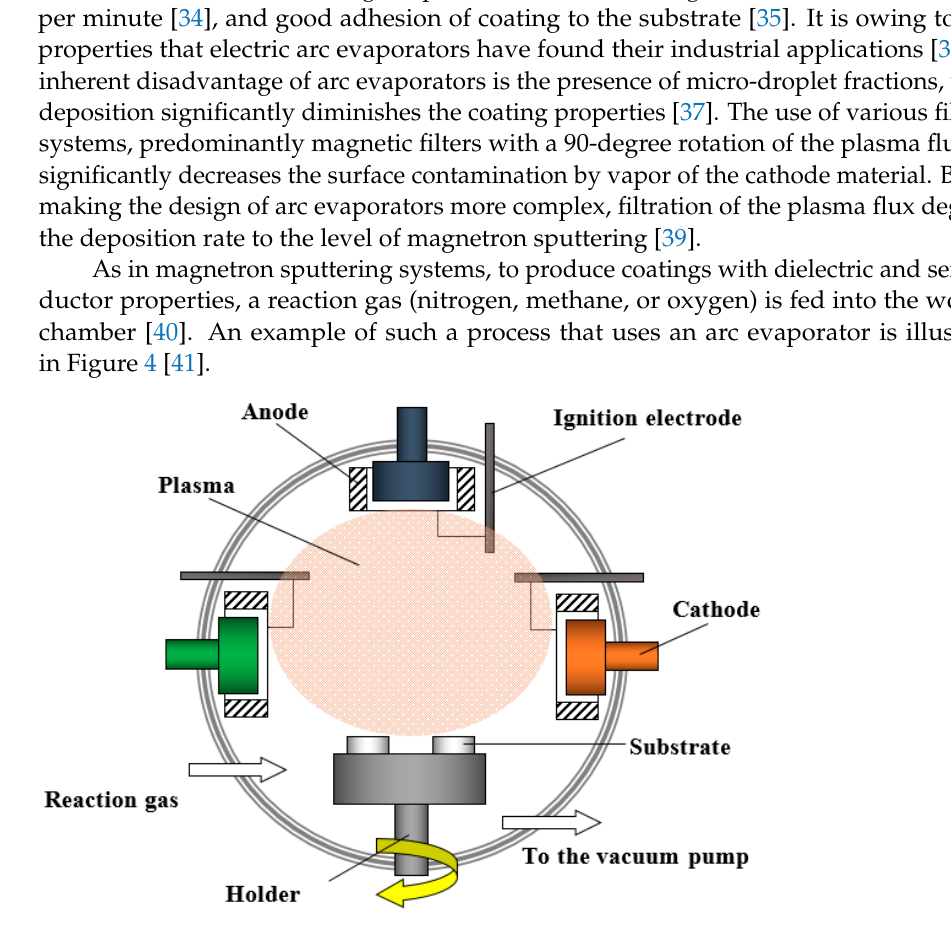
Figure 4. Schematic diagram of coating deposition by arc evaporation with an admission of a reaction gas [41].